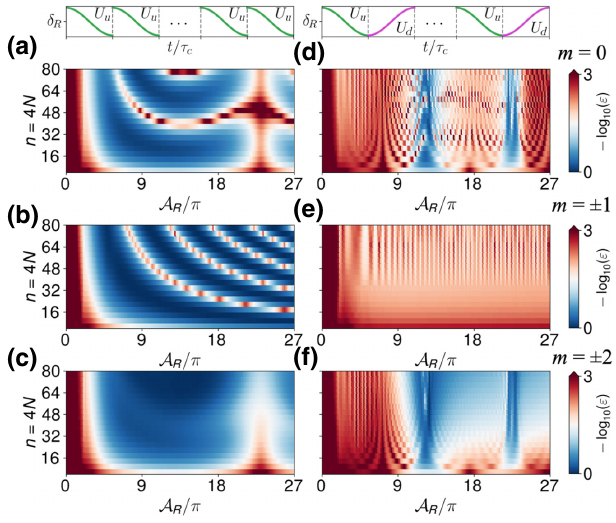
FIG. 6. Numerical results of spin leakage ε = ε ( 4 N ) for the m , (cid:2) m (left) and chirp-alternating ˜ U ( 4 N ) (right) as a traditional ˜ U ( 4 N ) uu ud function of kicking number 4 N and A R , with m = 0 (a),(d), m = ± (b),(e), m = ± 2 (c),(f). The two-photon detuning pro- files are illustrated on top of (a),(d). Additional parameters for the simulations are according to the experimental Sec. III C.